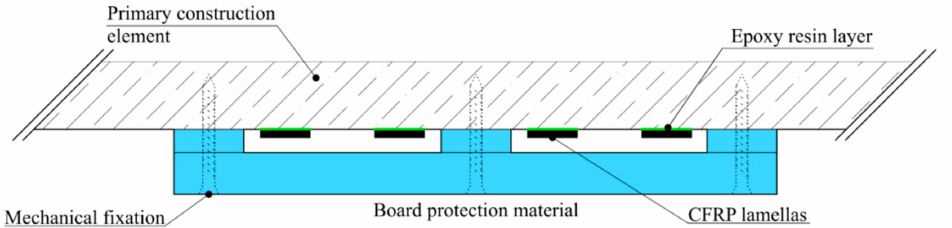
Figure 3. Protection of CFRP (Carbon-fiber-reinforced polymer) lamellas against elevated tempera- ture in epoxy resin layers by board